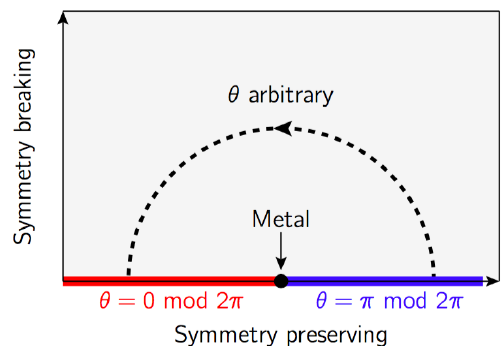
Figure 11: A schematic view of the possible values of θ as a function of both a sym- metry preserving parameter and a symmetry breaking parameter in a Hamiltonian as considered in Ref. [ 29 ] . Along the horizontal axis θ jumps from π mod 2 π to zero mod 2 π . The gap must close along the horizonal axis, whereas the topological class also changes, but the gap remains finite if the path is on the dotted circular